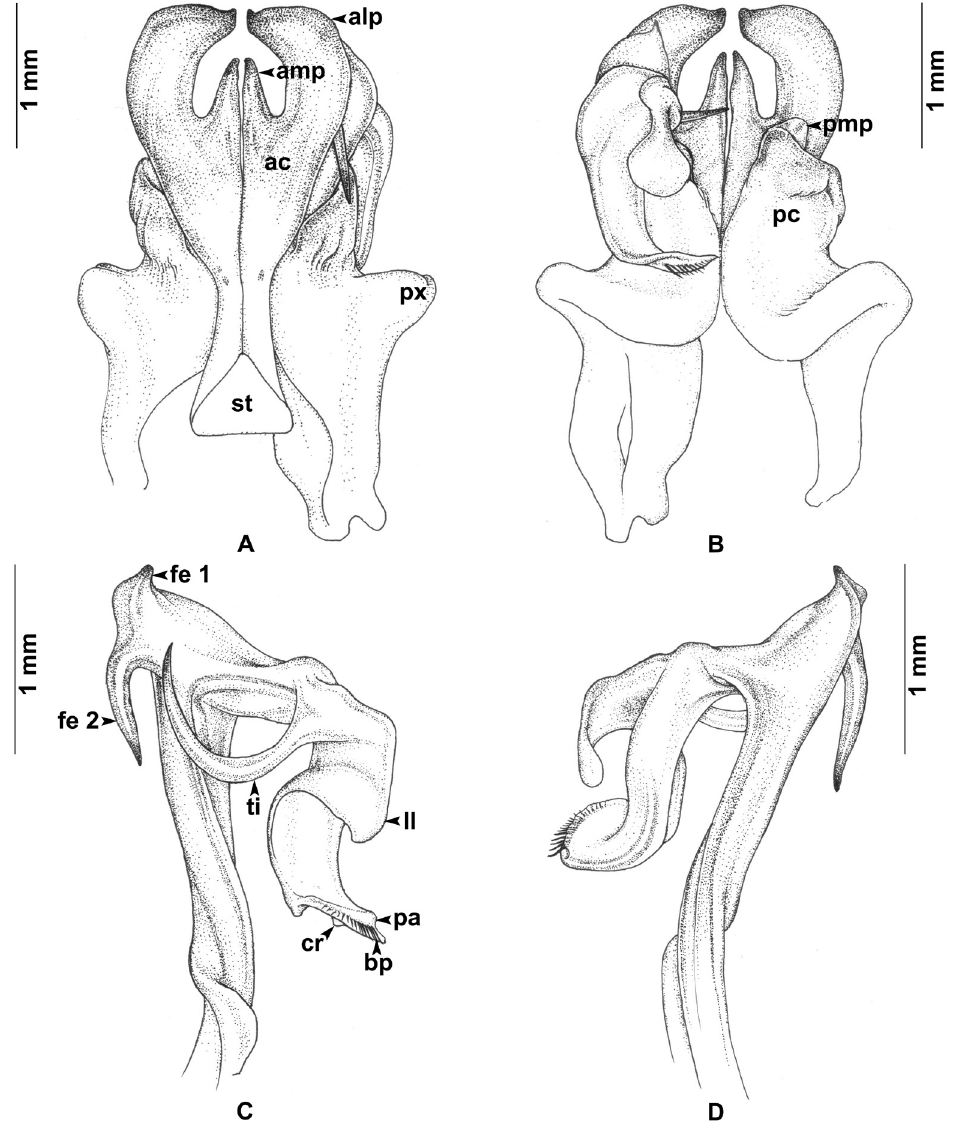
Fig. 10. Thyropygus ursus sp. nov., from Lanta Islands, holotype (NMHW-Inv.7855), ♂, gonopods. A . Anterior view, left telopodite removed. B . Posterior view, left telopodite removed. C . Left telopodite, posterior-mesal view. D . Left telopodite, anterior-lateral